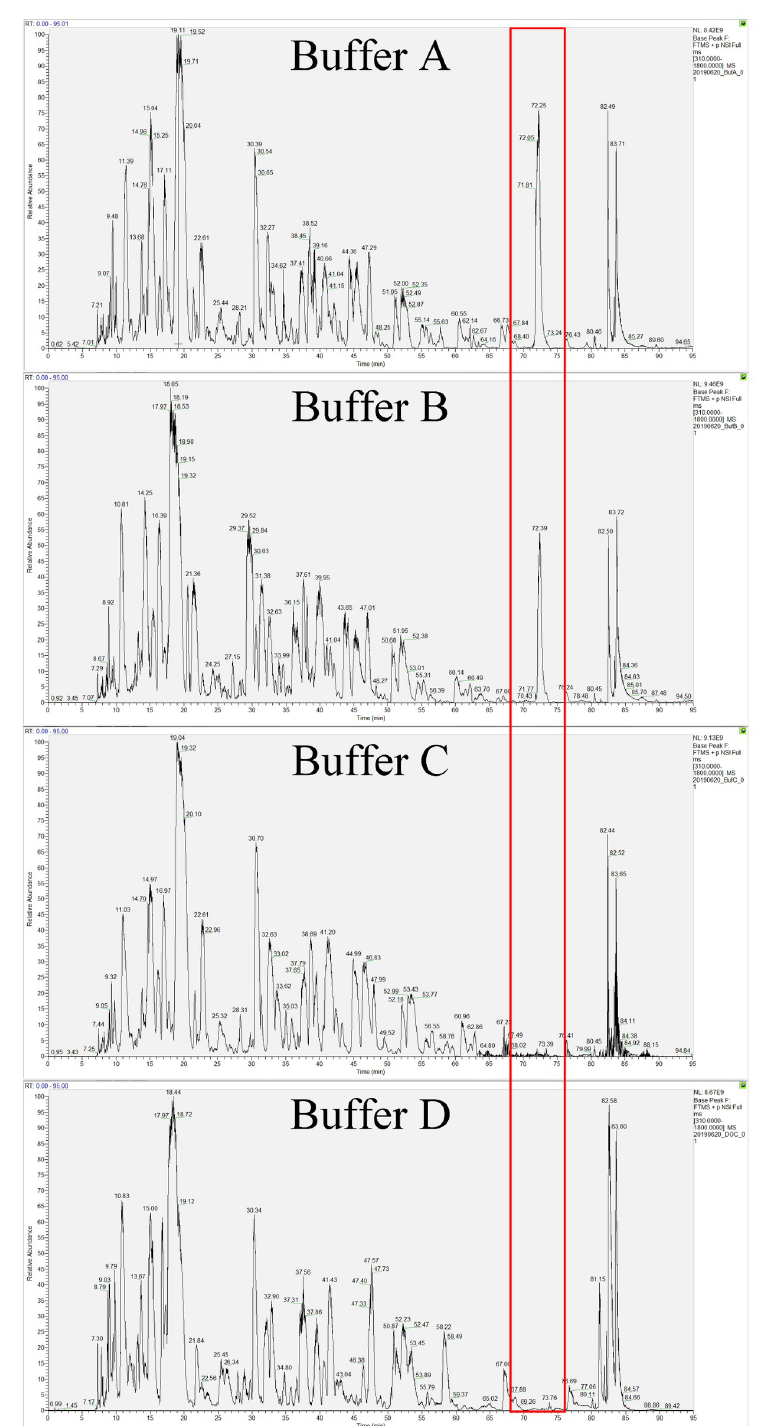
Fig 1. Base peak chromatogram of peptides digested from the four solubilization buffers (A-D, from top). Red box indicate the contaminant peaks (CHAPS). Buffer A: Urea/thiourea/CHAPS; Buffer B: Urea/CHAPS; Buffer C: Urea/Sodium deoxycholate; Buffer D: Sodium